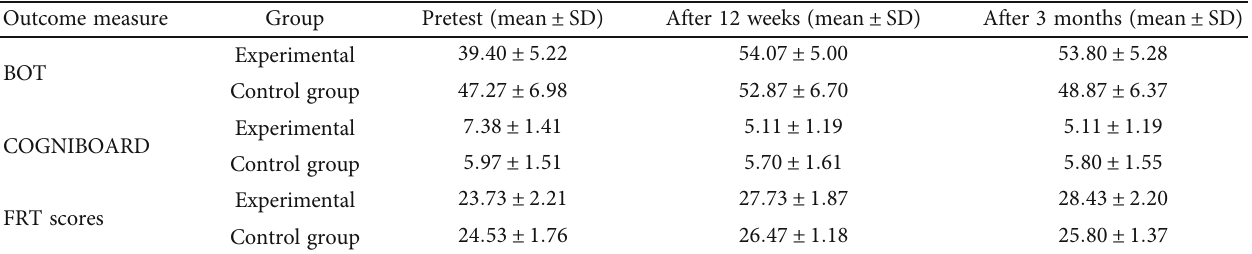
Table 2: Performance of both groups in the BOT2, COGN İ BOARD, and Functional Reach Test in the outcome analysis at three given time points.